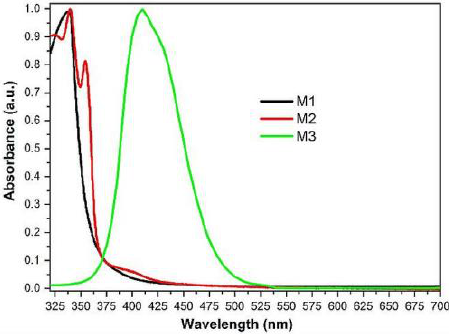
Energies 2023 , 16 , x FOR PEER REVIEW Figure 3. UV-vis absorption spectra of investigated compounds: in CH 2 Cl 2 (c = 1 × 10 −5 M). Figure 3. UV-vis absorption spectra of investigated compounds: in CH